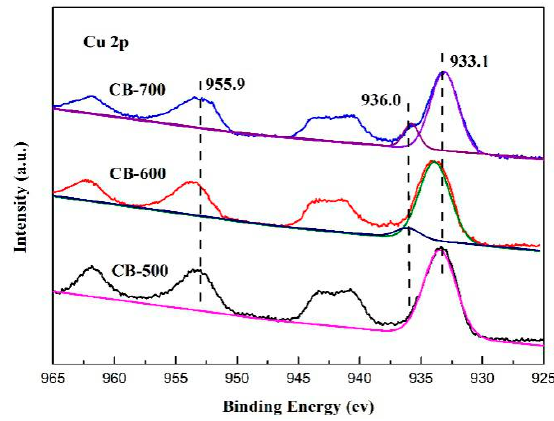
Figure 4. X-ray photoelectron spectroscopy (XPS) spectra of fresh and used CB-600 catalysts.